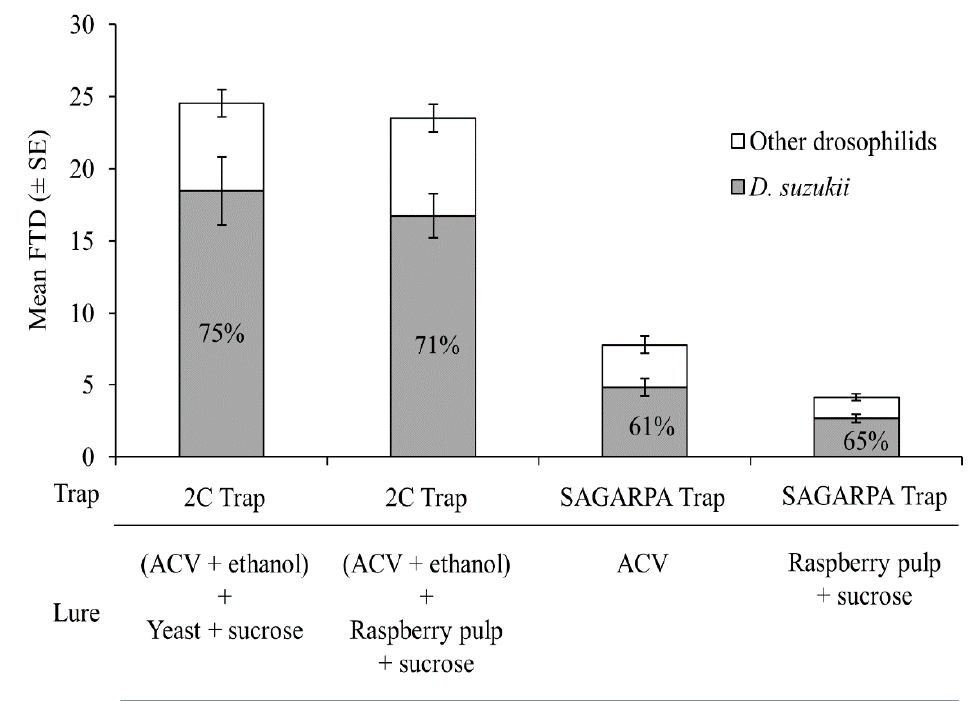
Figure 6. Mean numbers of flies/trap/day (FTD) for D. suzukii (grey columns) and other drosophilid species (white columns) trapped in 2C traps and SAGARPA traps baited with different lure combinations that were evaluated in a commercial polytunnel blackberry production system.